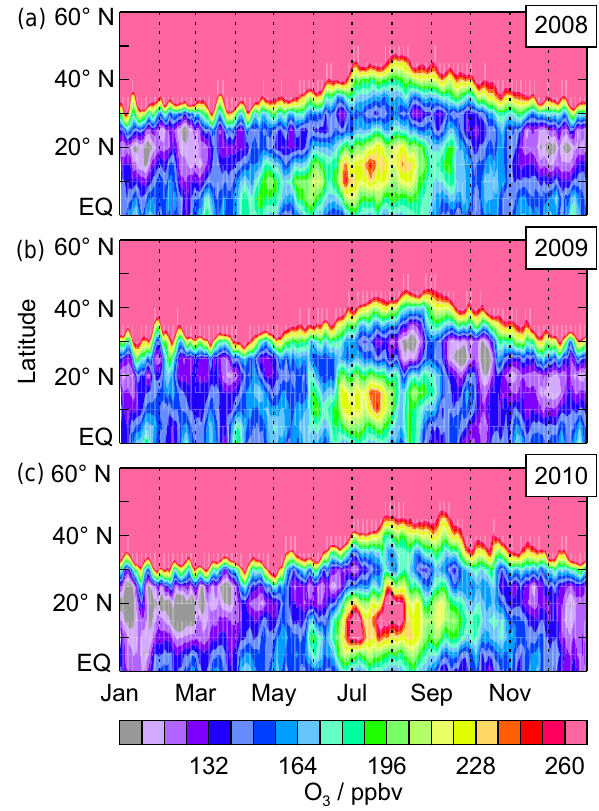
Figure 9. Zonally averaged (10 ◦ –130 ◦ E) time series of MLS ozone at θ = 380K (version 4.2; for more details see Santee et al., 2017) over the course of these 3 representative years (a–c) 2008 (after La Niña winter), 2009 (a normal year) and 2010 (after El Niño